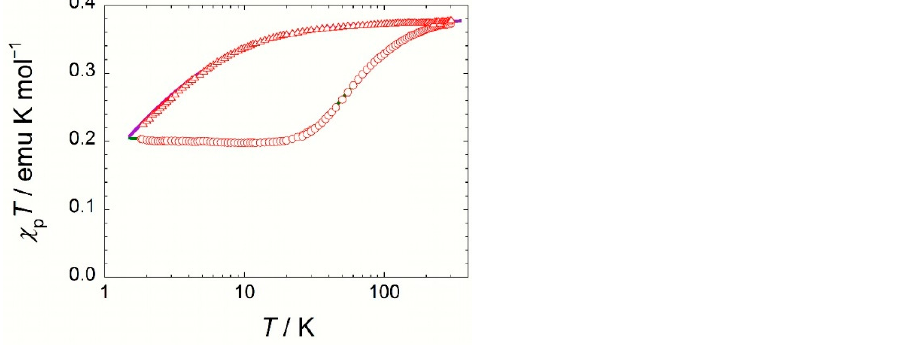
Figure 2. Temperature dependences of χ p T of 2-BTHNN (open circles) and 2-BTHIN (open triangles). The solid line for 2-BTHNN indicates a fit using the two-magnetic-dimer model (see the text).